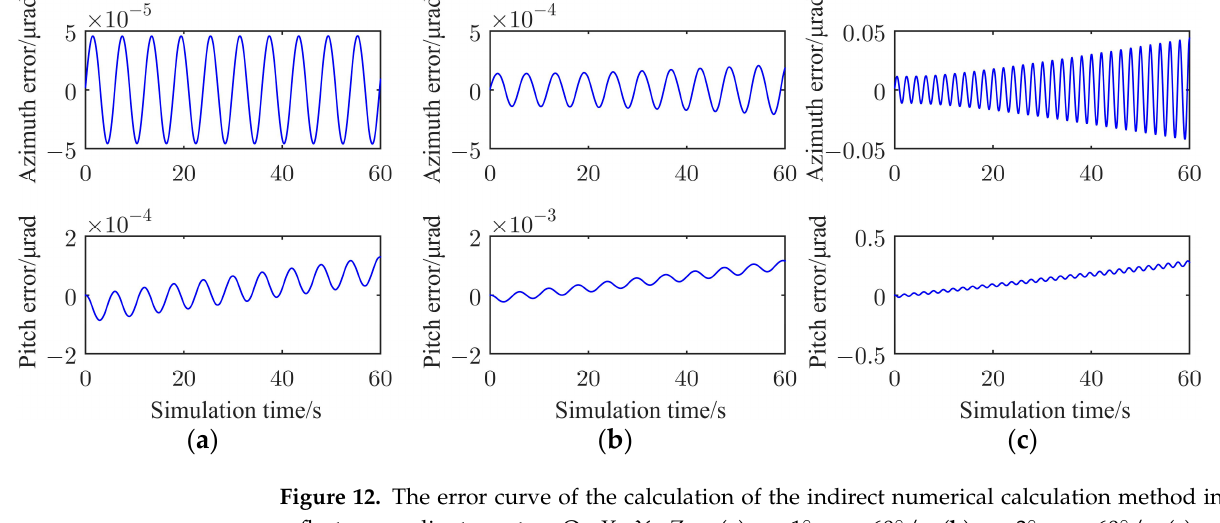
Figure 11. The LOS a tt itude curves under the condition of conical motion in an ideal state in the